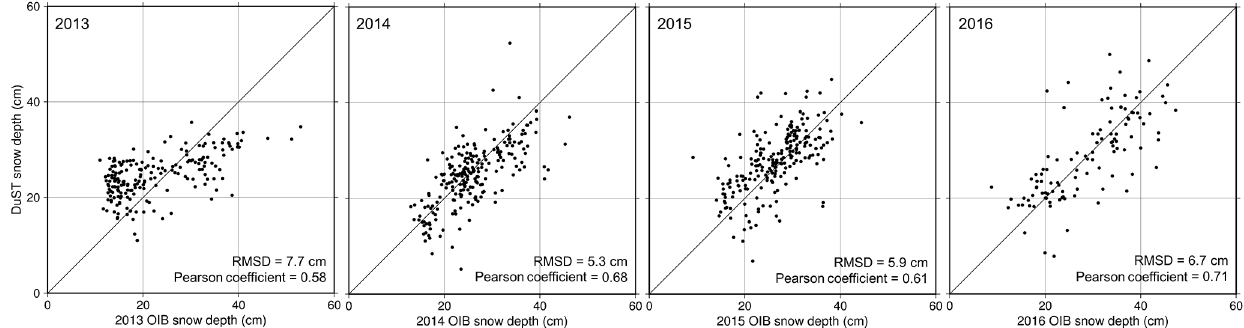
Figure 8. Comparison of DuST and OIB snow depths for the 2013, 2014, 2015, and 2016 spring campaigns. Statistical results for all years are summarised in Table 3.